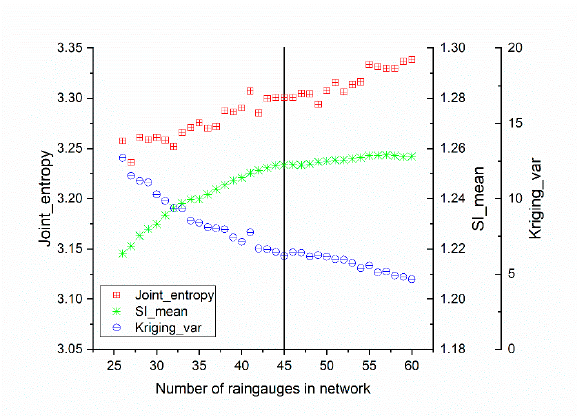
Figure 11. Statistics of the optimum design results for a station network of 60 rain gauges.